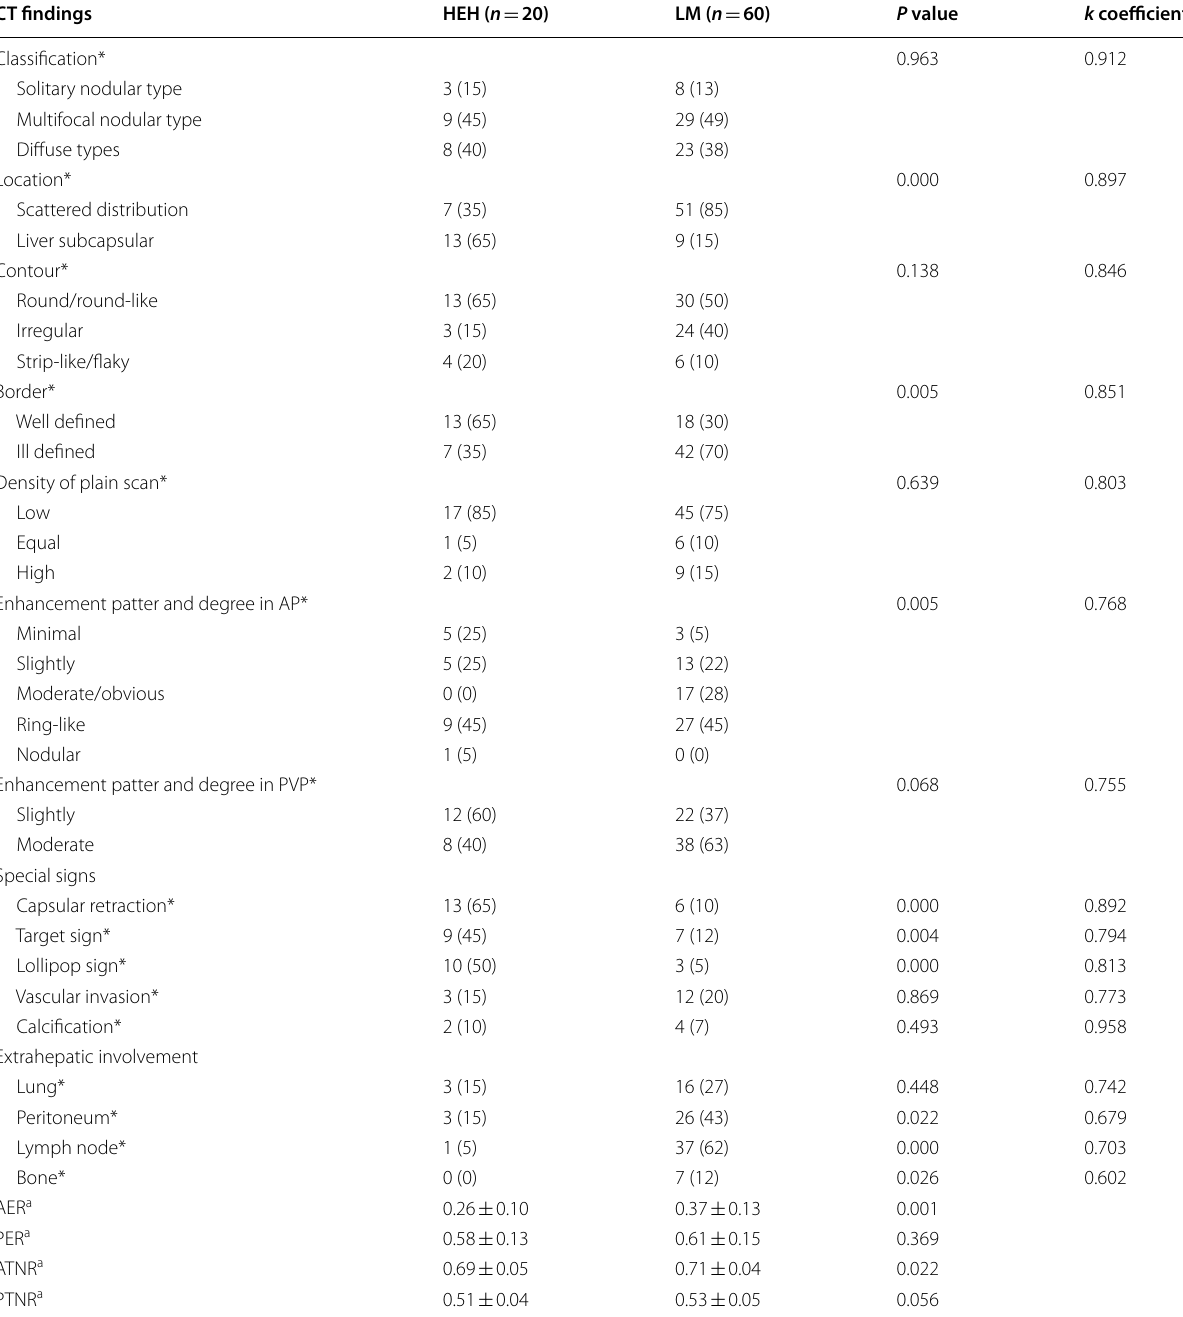
Table 4 Comparison of quantitative and qualitative CT findings between HEH and